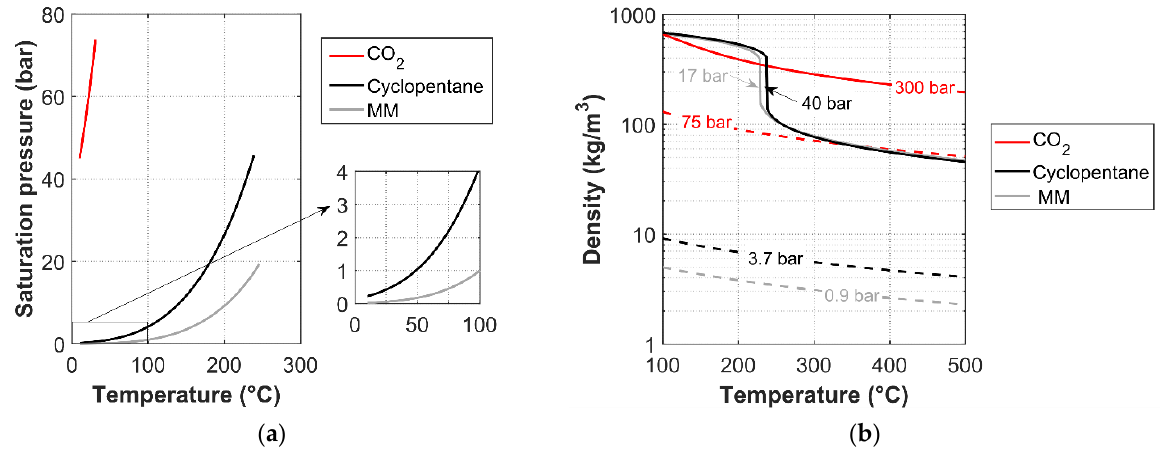
Figure 5. Fluid thermodynamic properties: ( a ) saturation pressure; ( b ) density (calculated with Refprop [27]).